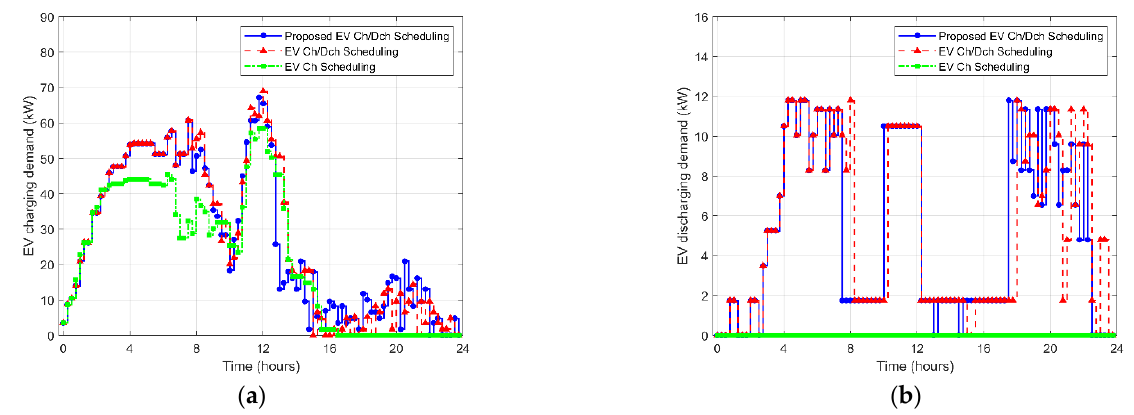
Figure 11. ( a ) The charging demand of parked EVs; ( b ) the discharging demand of parked EVs.